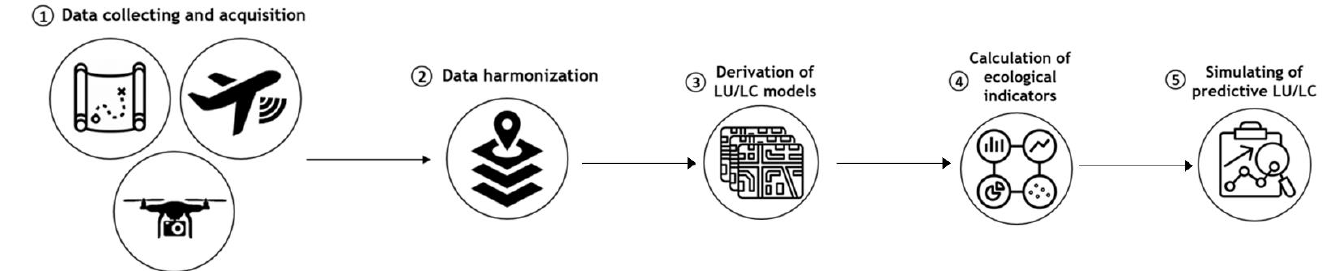
Figure 2. Simplified methodological framework of the research.